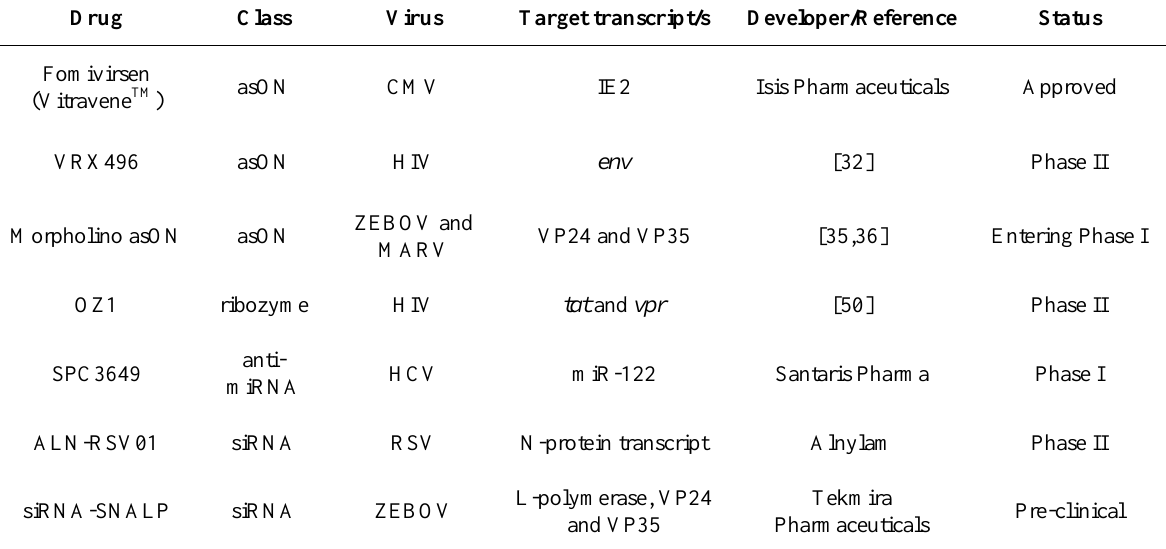
Table 1. Antiviral oligomeric nucleic acids in clinical